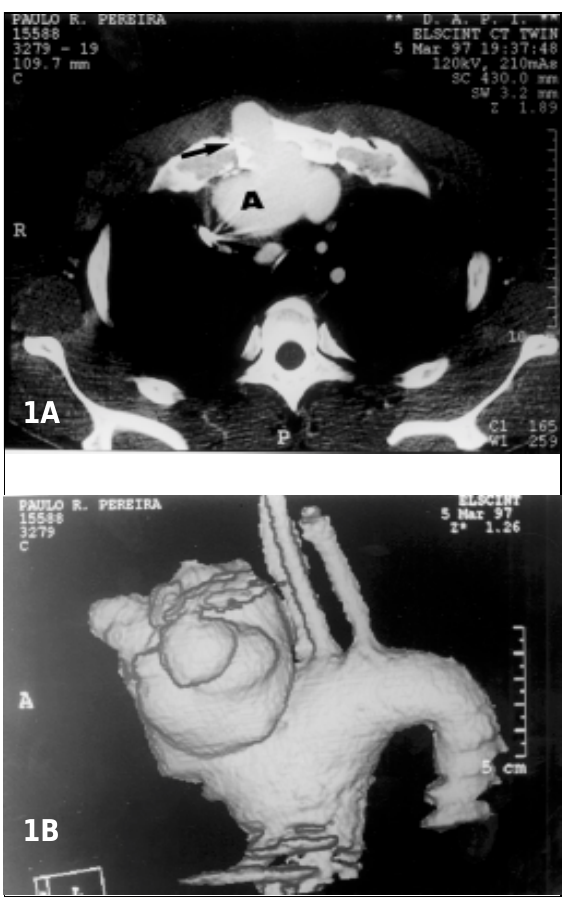
Fig. 1 A – Tomografia computadorizada de tórax demonstrando a erosão completa do esterno provocada pelo aneurisma. A = aneurisma; flecha = local da erosão Fig. 1 B – Angiotomografia tridimensional onde se observa grande aneurysma da aorta com suas